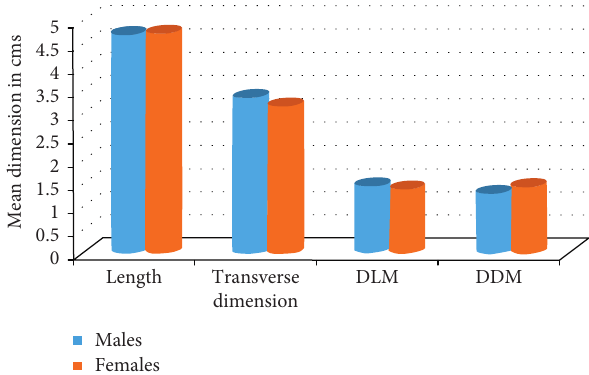
Figure 5: Graph showing comparison of ultrasonographic mea- surements of parotid glands in males and females in study subjects. Ultrasonographic measurements in study and control subjects (Table 1 and Figure 6).